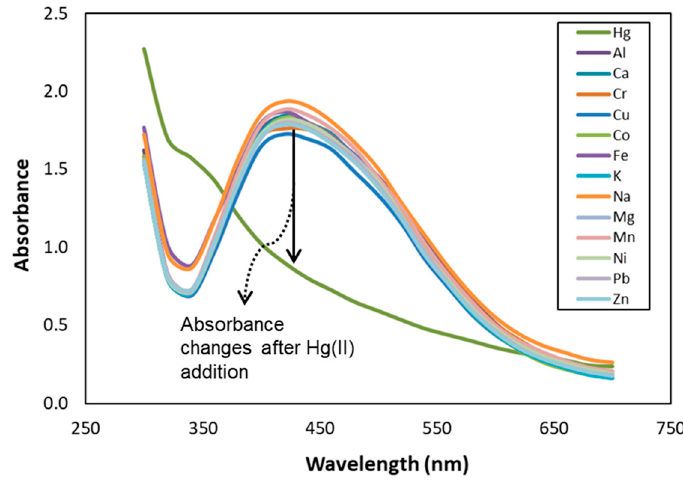
Figure 1. Change in absorbance of the silver nanoparticles’ (AgNPs) colloid in the presence of 60 ppm Hg(II) and other metal ions.